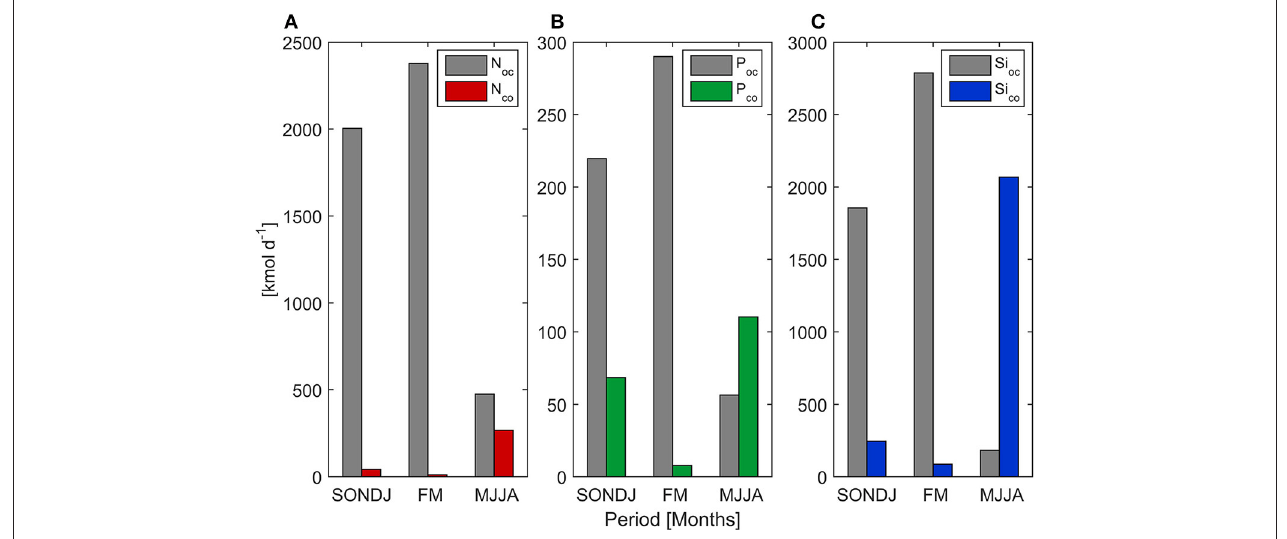
FIGURE 4 | Mean value of Nitrate (A) , Phosphate (B) , and Silicate (C) flux from upwelling ( oc ) and river discharge ( co ) during three periods of the